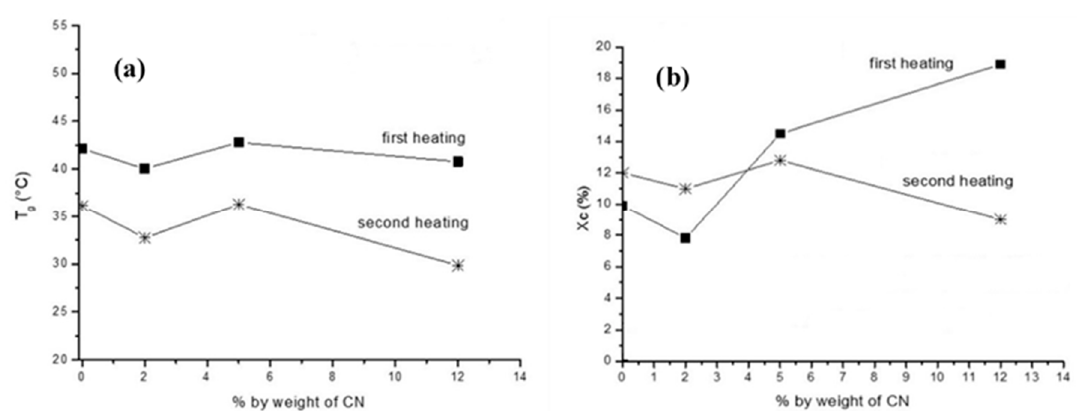
Figure 16. ( a ) Analysis of thermal properties from first and second heating steps in PLA / CNF nanocomposites: Trend of T g as a function of CNF concentration. ( b ) Analysis of thermal properties from first and second heating steps in PLA / CNF nanocomposites: trend of crystallinity as a function of CNF concentration [81].